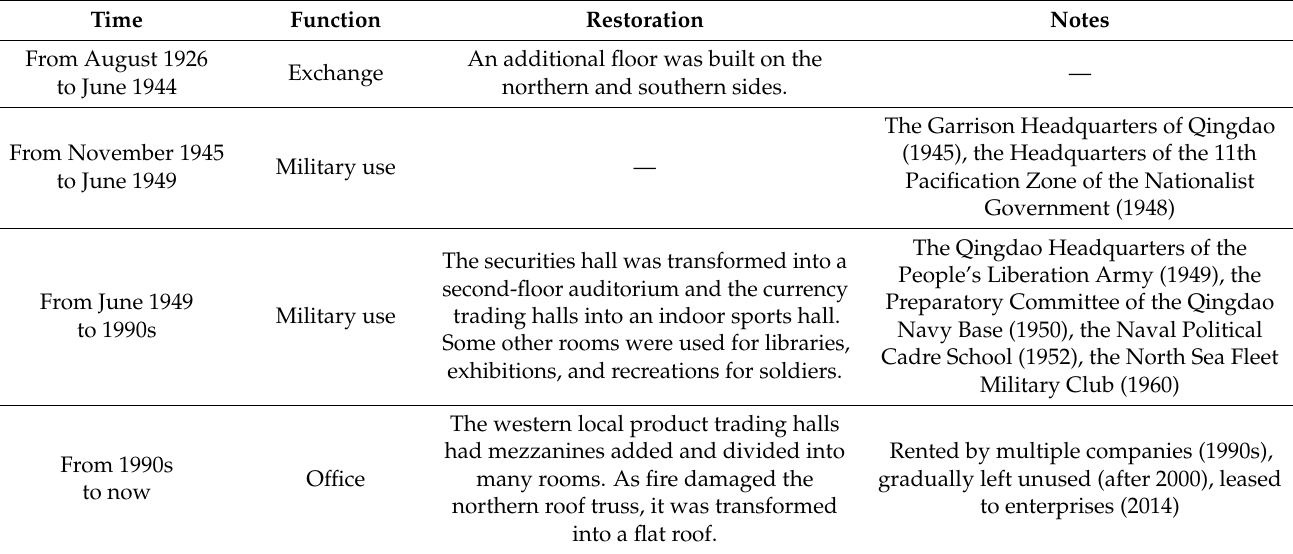
Table 1. The History of Refunctioning and Restorations of Qingdao Exchange Building.